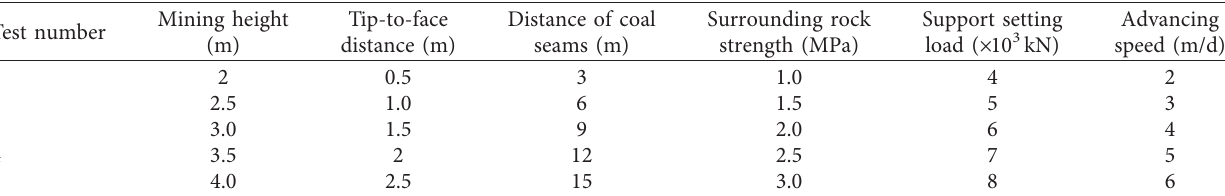
Table 3: Level values of each factor.